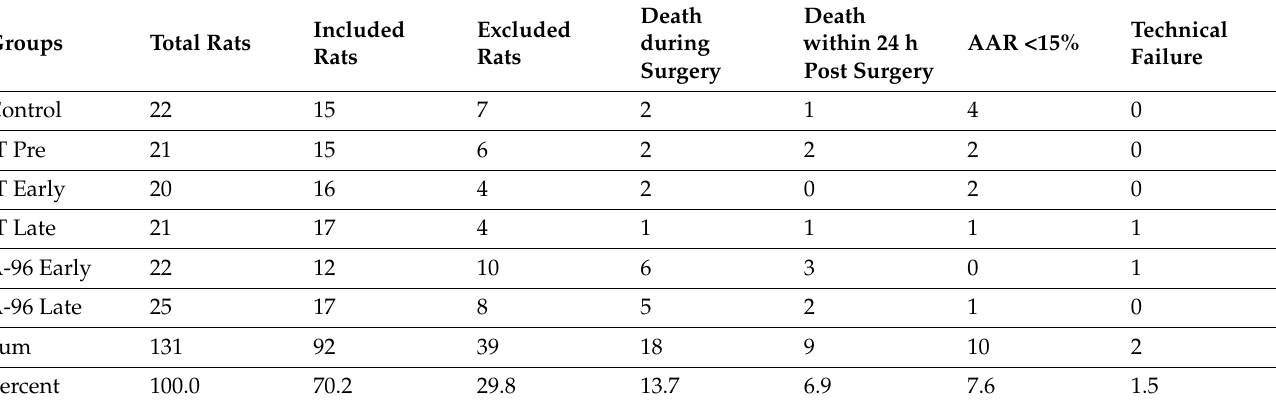
Table A1. Rat exclusion criteria. The total number and the number of included and excluded rats for each treatment group. The excluded rats are additionally separated by the reason for exclusion. The percentage of animals which died during surgery was 9% (2/22) for control, 12% (5/41) for JT010, and 23% (11/47) for treatment with A-967079. These numbers are not significantly different (Fisher’s exact test p = 0.28), but it should be noted that these experiments were not powered to detect potential differences.